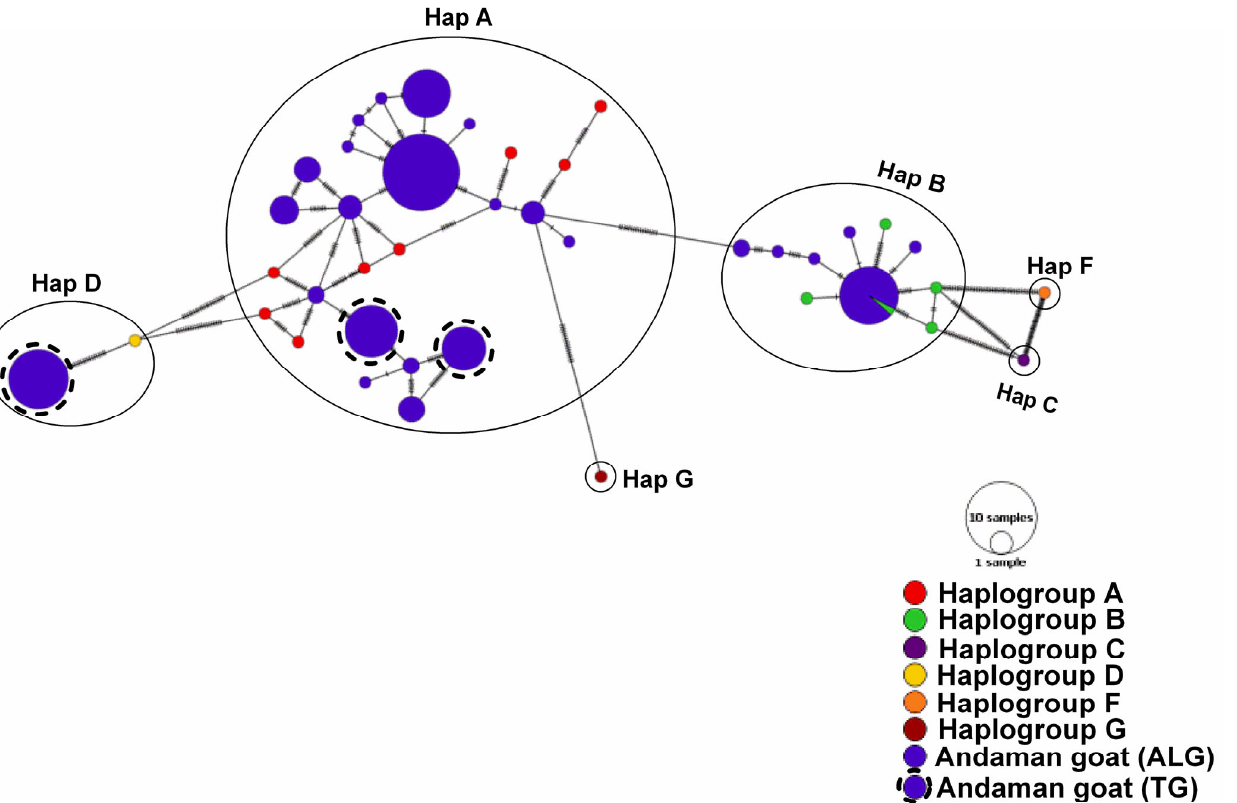
Figure 1. Haplogroup assignment of di ff erent haplotypes of Andaman goats. The GenBank acces- sion numbers of the standard haplogroups used are as follows; A = KR059184, KR059151, KR059152, KR059167, KR059171, KR059175, KR059178, KR059180; B = KR059219, EF618257, EF618222, EF618355, DQ121514, AY860894; C = GU229280; D = KR059210; F = KR059226 and G = KR059213. The network map was drawn in PopART ver. 1.7 [34]. The network map was constructed based on a 481 bp hypervariable region (HV1) of goat mt. DNA D-loop.